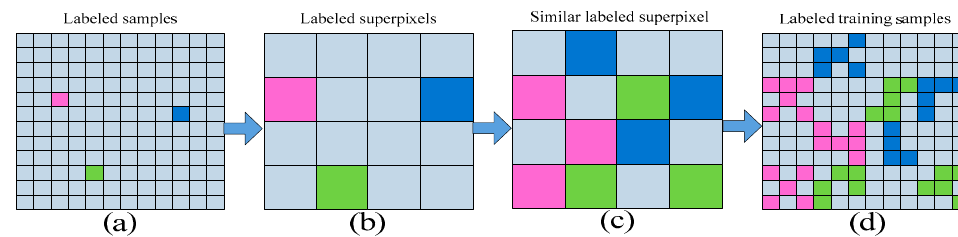
7 of 22 Figure 2. The structure of relation network. 2.4. Pseudo-Labels Generation Algorithm In few-sample problems, the classifier trained only with support set samples has poor classification performance due to a scarcity of labeled samples. According to this problem, the RN carries out meta-learning algorithm on the source domain in order to derive trans- ferable information so that we can carry out better feed efficiency from shot learning of the support set and more successfully classify the test set. Therefore, source domain data